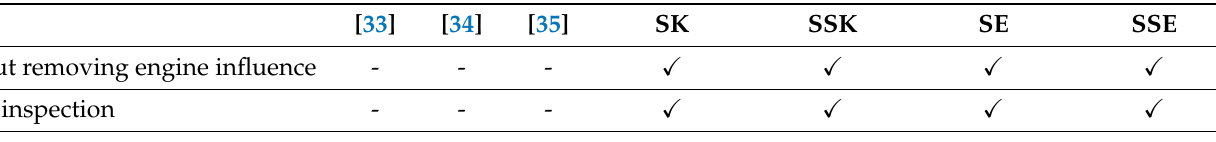
Table 7. Training classifier accuracy of each filtering approach in Case Western Reserve University (CWRU) dataset compared with several recently reported state-of-the-art works.